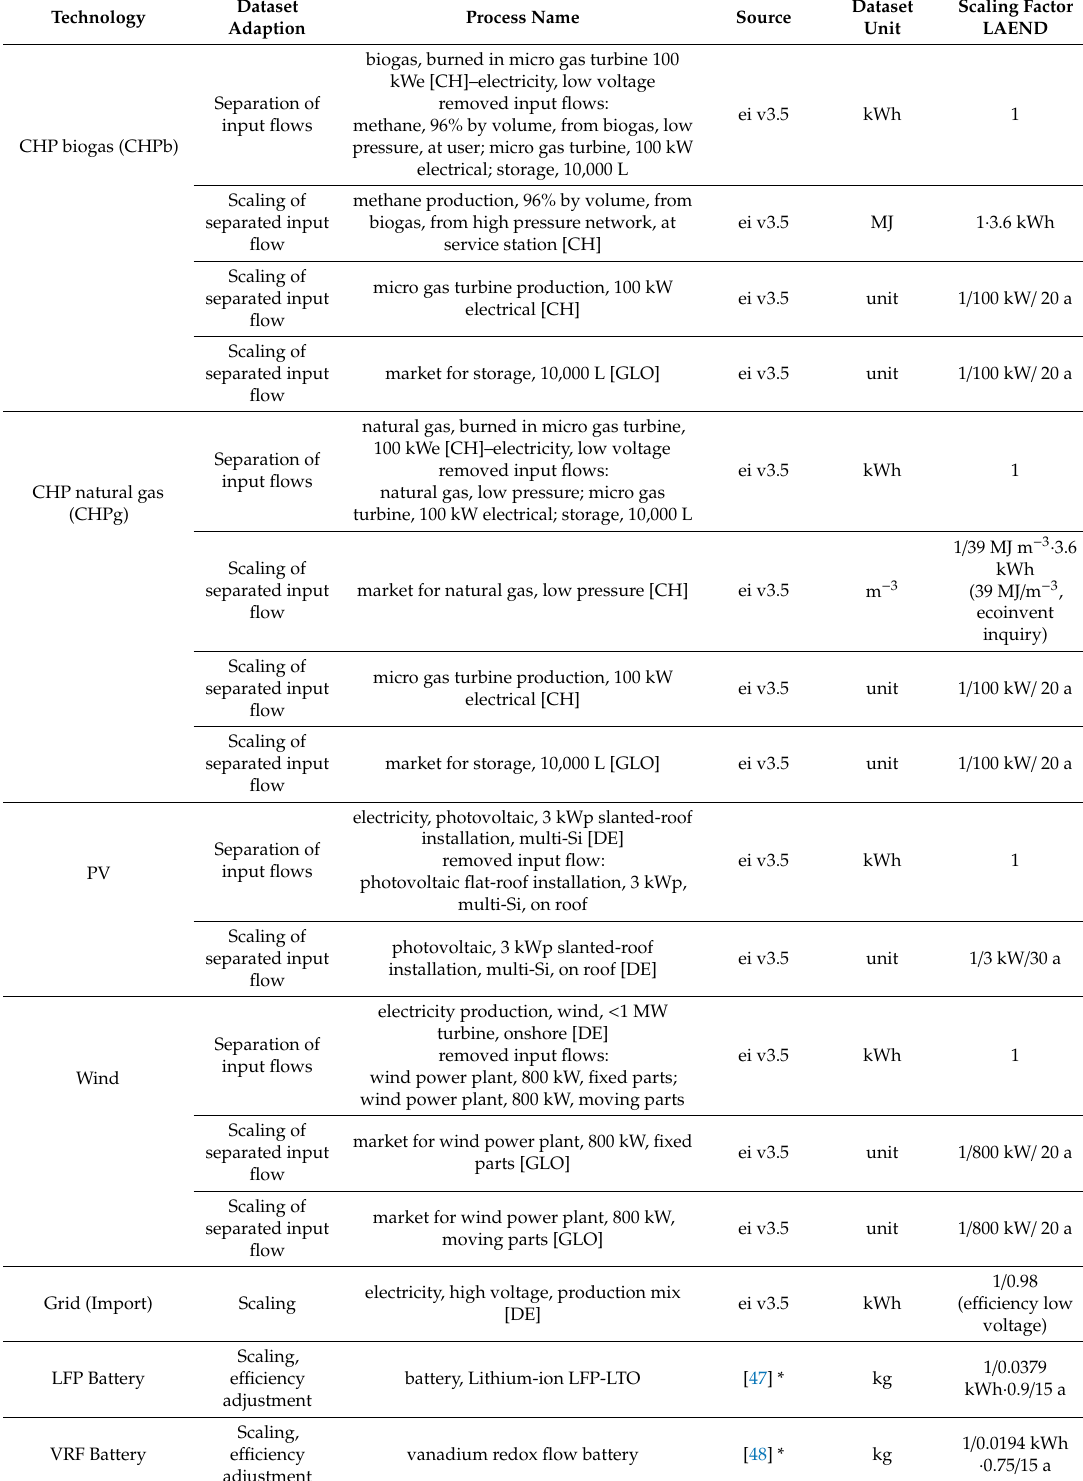
Table A2. LCI datasets used for LAEND with adaptions and scaling factors to combine oemof values and LCI